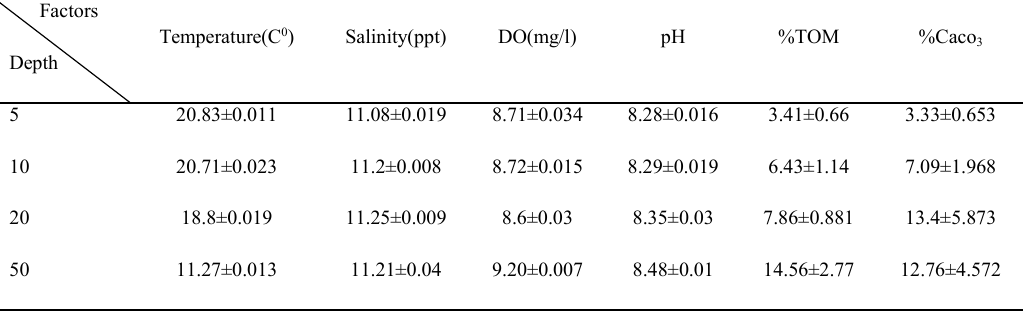
Table 3: The Mean of Temperature, Salinity, DO, pH, Total Organic Matter (TOM) and Caco3 in different Seasons the southern Caspian Sea from Behshahr to Ramsar (±SD).